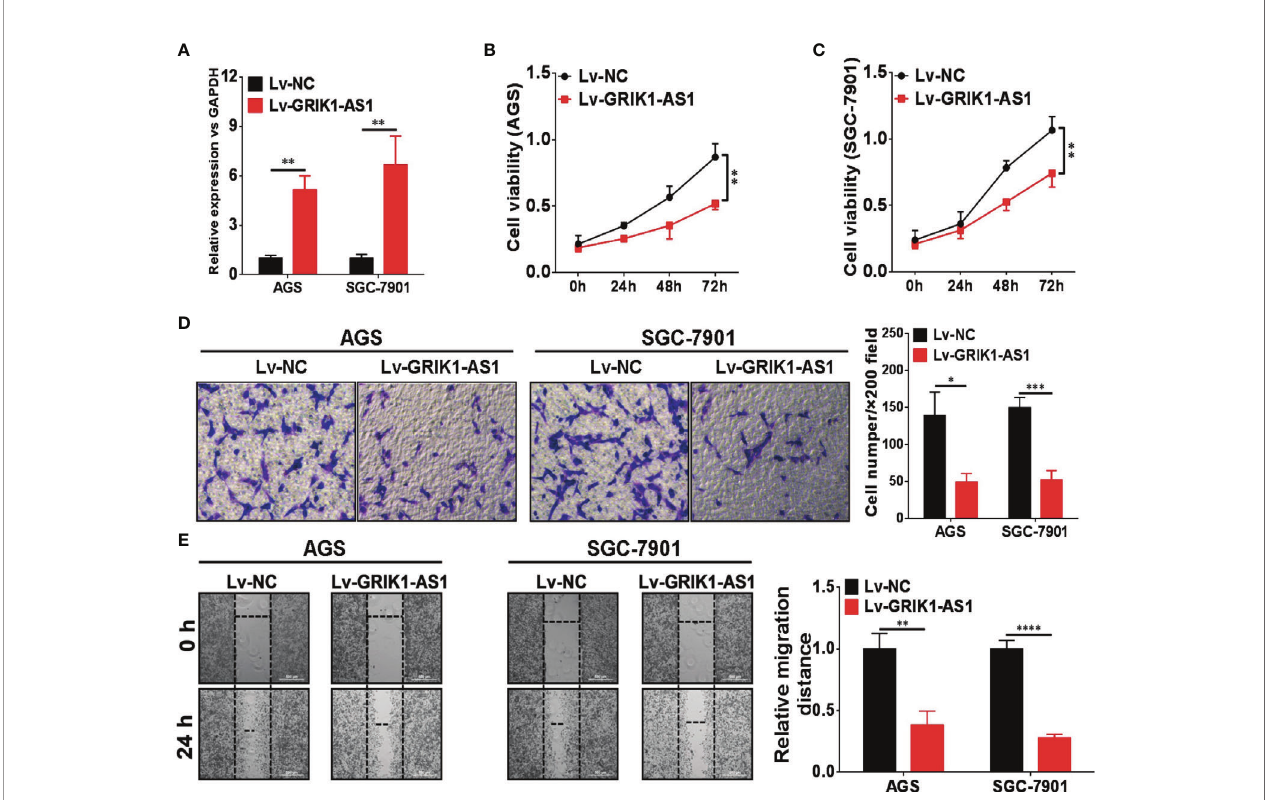
FIGURE 2 | LncRNA GRIK1-AS1 inhibits cell proliferation and invasion in vitro . (A) Real-time qPCR shows the expression level of GRIK1-AS1 in gastric cancer cells AGS and SGC-7901 and its over-expression. (B, C) Cell proliferation assays of GRIK1-AS1 over-expressed AGS and SGC-7901 cells. (D) Invasion capability analysis of GRIK1-AS1 over-expressed AGS and SGC-7901 cells by transwell assays. (E) Migration ability analysis of GRIK1-AS1 over-expressed AGS and SGC- 7901 cells by wound healing assays. * P < 0.05, ** P < 0.01, *** P < 0.005, **** P <